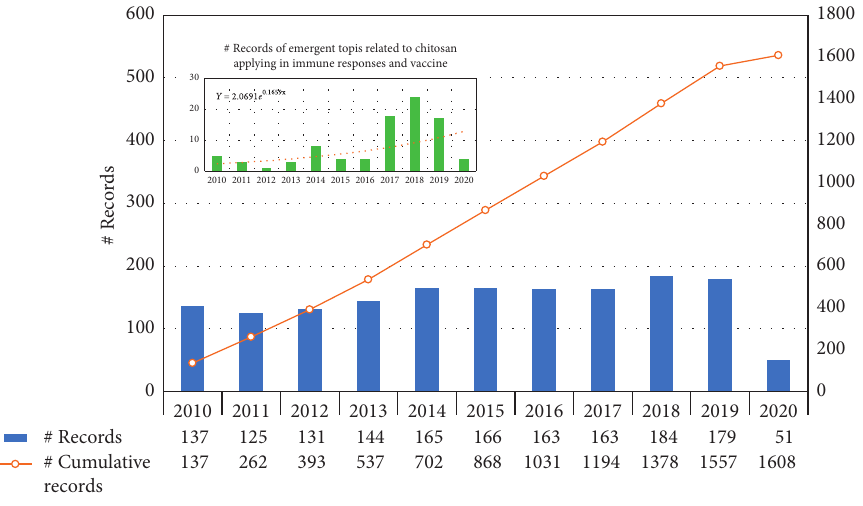
Figure 2: Annual distribution of papers on chitosan applications in viral disease treatment. Table 1: Top five journal publishing in the field of chitosan